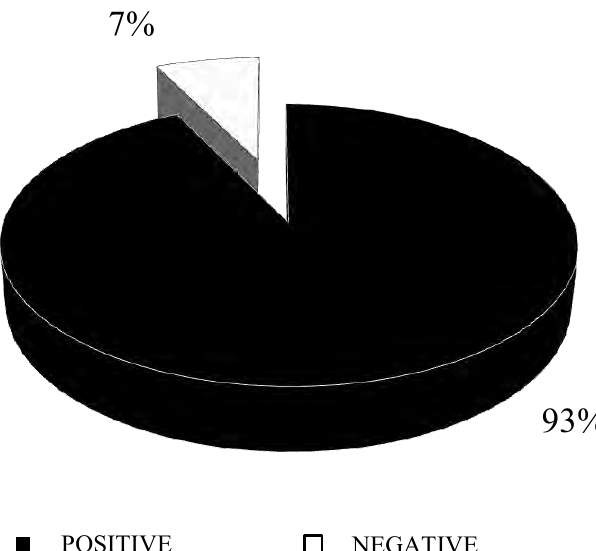
Fig.1. Comparative statistics of matches’ quantity during season, conducted by highly qualified referees of Ukraine and advanced football championships of Europe (season 2012-2013.).